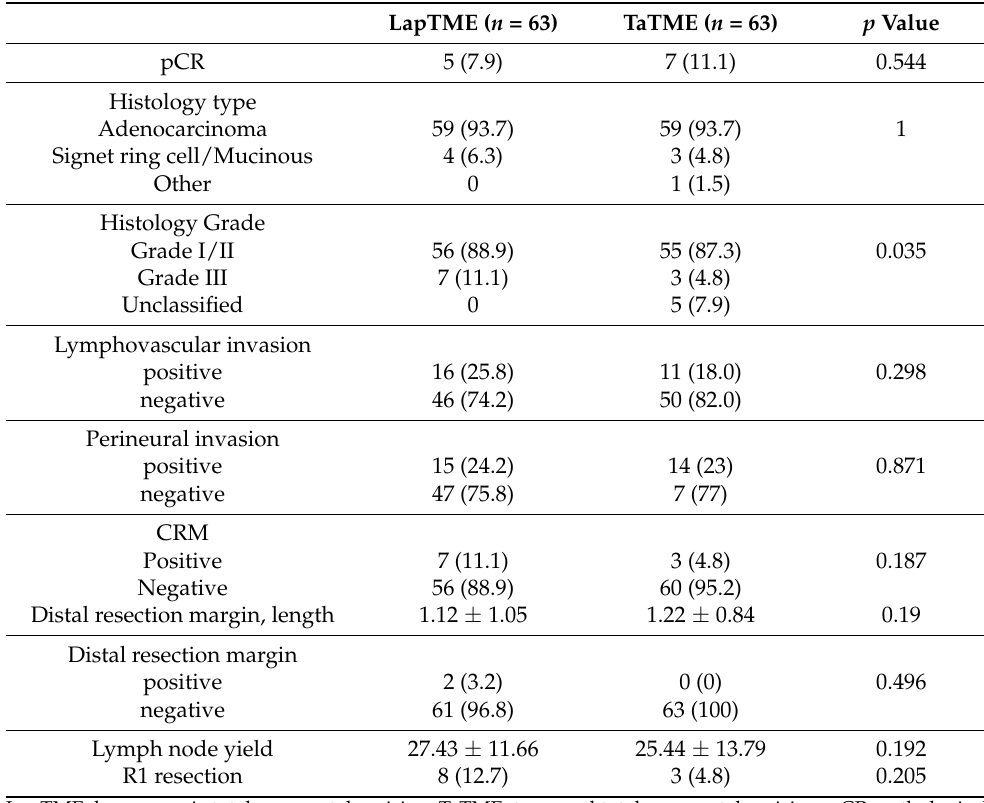
Table 4. Post-matching pathological finding among patients with low rectal cancer underwent restorative proctectomy.